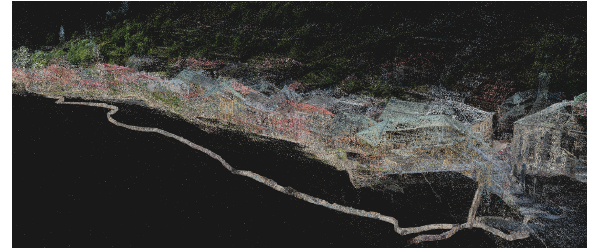
Figure 28. Pointcloud of town reserve with stole Glanzenberg